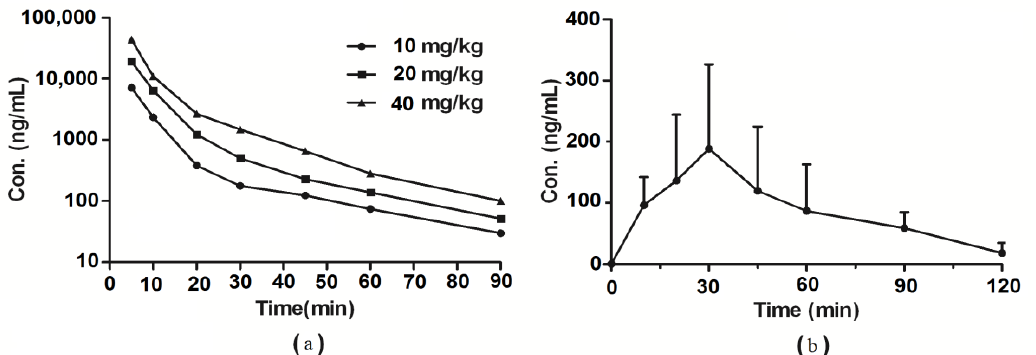
Figure 2. Mean plasma concentration-time profiles of wogonin in rats after receiving a single i.v. dose at different concentration levels (10, 20 and 40 mg/kg wogonin, n = 6) ( a ) and plasma concentration-time (mean ± SD) profile of wogonin in rats following i.g. dose of 100 mg/kg wogonin; ( b ) ( n =